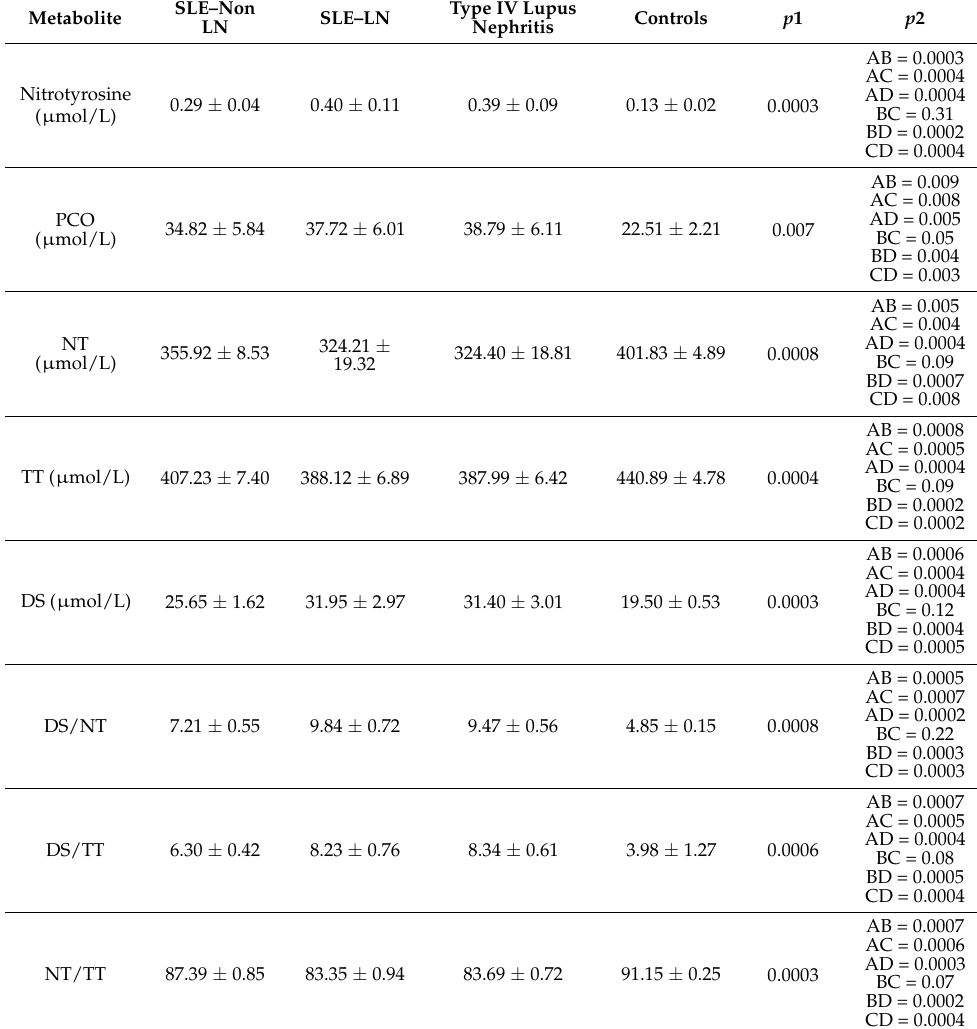
Table 6. Oxidized protein pattern in the studied